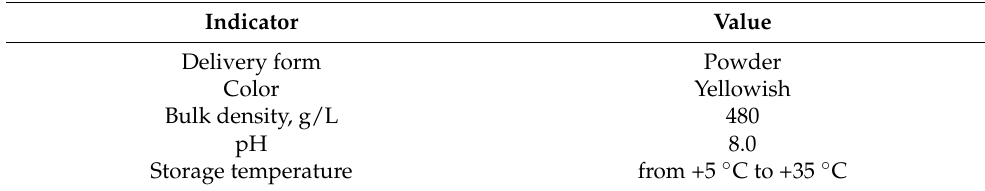
Table 4. Technical description of MELFLUX 1641 F